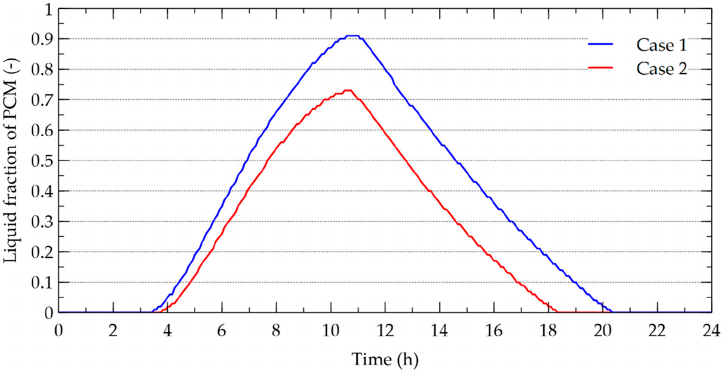
Figure 17. Estimated liquid fraction of PCM.